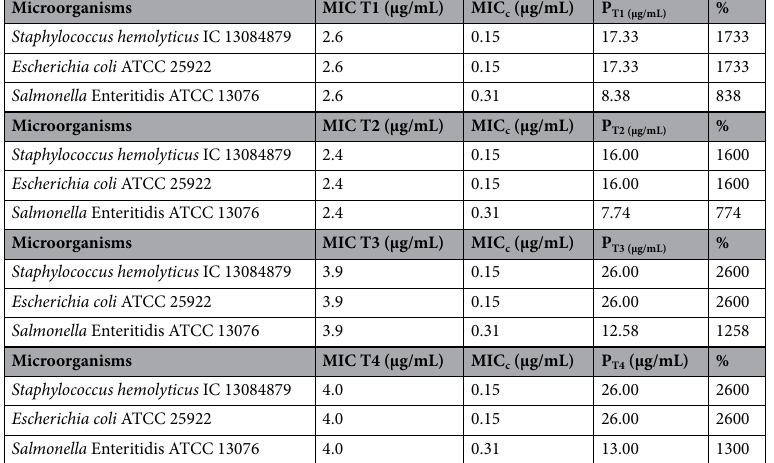
Table 7. Determination of potency of triazene compounds in comparison to the activity of the known antibiotic chloramphenicol [20 µg/mL].